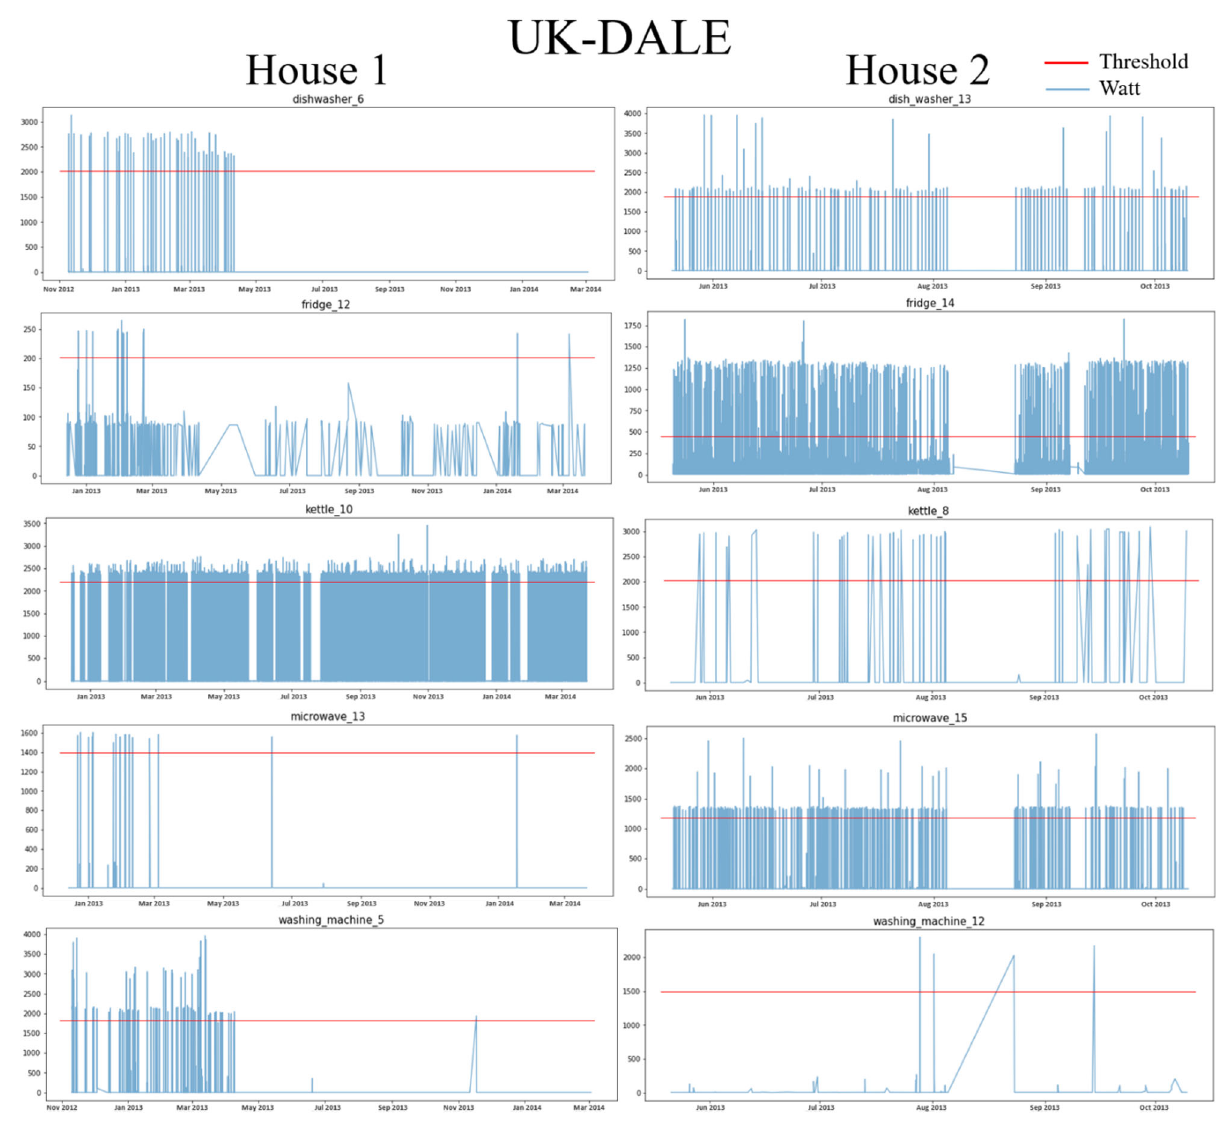
Figure 3. Power Usage and ON Thresholds for House 1 and House 2 in the UK ‐ DALE dataset.